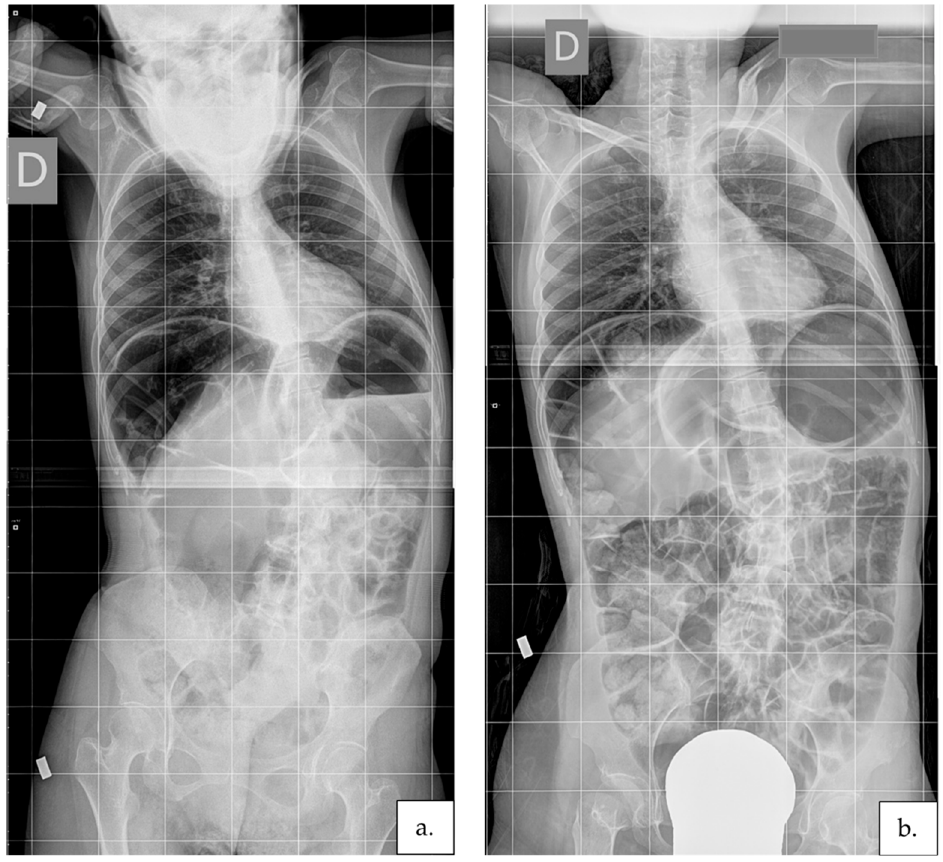
Figure 4. Participant no. 11 ′ s radiographs collected before ( a ) and after ( b ) the intervention. She was 31.6 years old at T1 and used to sit with trunk supported for most of her waking hours. She was able to stand and walk only with significant support given at the trunk from behind. During the intervention, she started a daily program of unsupported asymmetrical sitting, walking on a treadmill, and overcorrecting passive posture maintenance. At the end of the intervention, she was able to walk more than 10 steps and stand for more than one minute with support given to the distal section of both hands. An improvement of 11 ◦ Cobb was recognized at